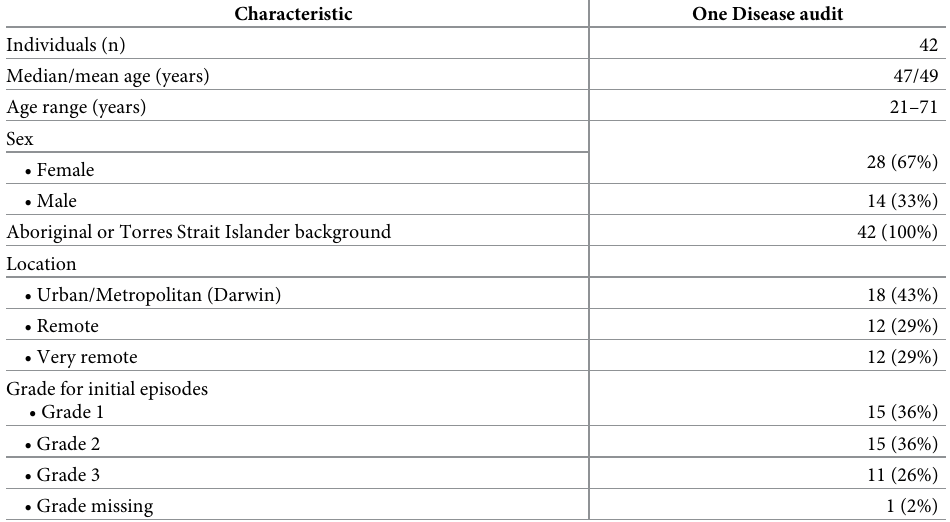
Table 3. Characteristics of individuals with episode of crusted scabies between July 2016—May 2018, Top End Northern